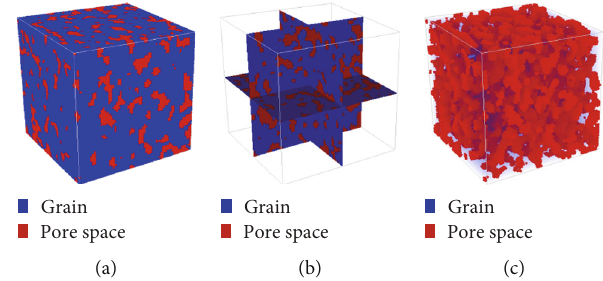
Figure 5: TI of shale: (a) exterior; (b) cross-sections ( X = 32 , Y = 32 , and Z = 32 ); (c) pore